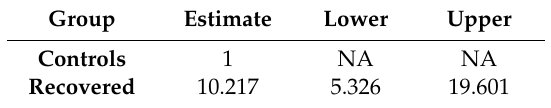
Table 4. Odds ratio related to symptoms in recovered patients. Odds with 95% CI. Group